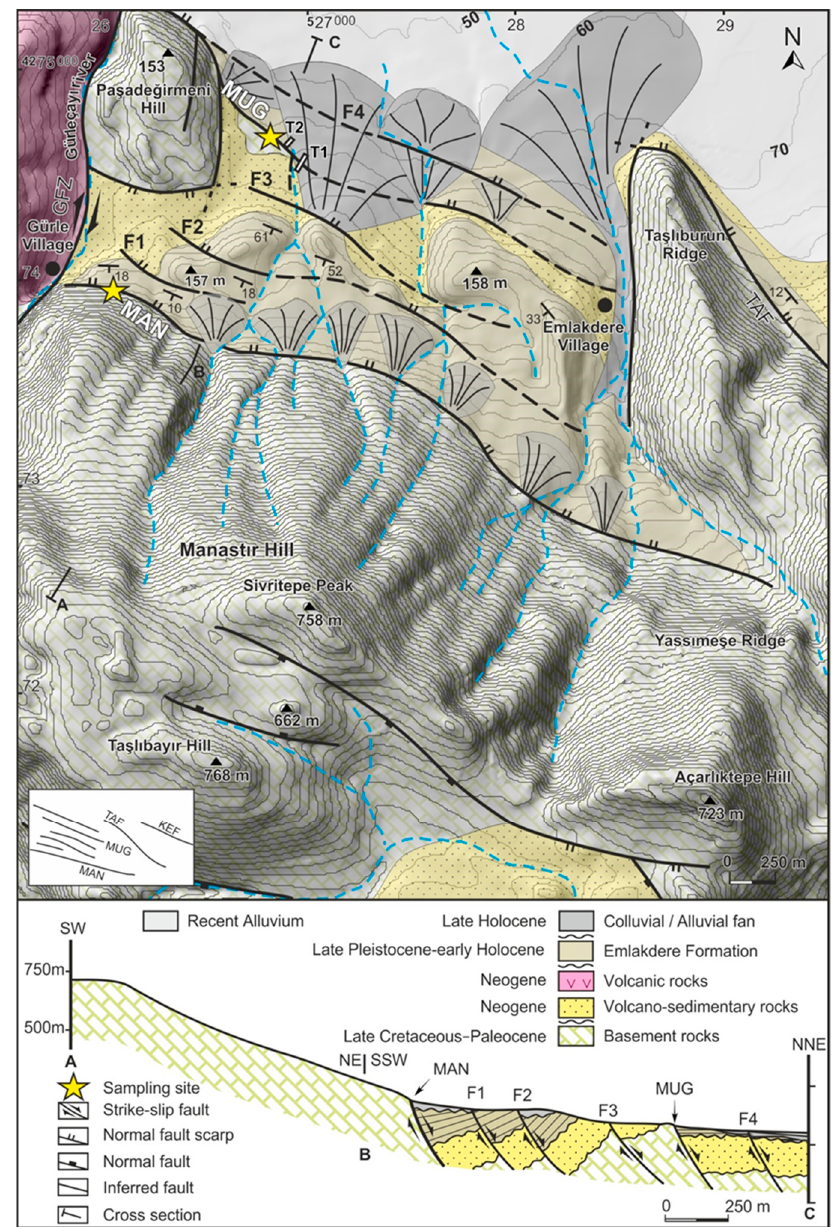
Figure 3. Detailed geological map of the study area showing NW–SE-trending active faults; location of paleoseismological trench sites from [59] along Mugırtepe fault are shown as T1 and T2. Yellow stars locate fault scarp dating sampling sites of Manastır (MAN) and Mugırtepe (MUG) faults, respectively. GFZ: Gürle Fault Zone, TAF: Ta¸slıburun fault, KEF: Keçiliköy fault; Inset is a simple sketch to show Ta¸slıburun fault, which its location is beyond the map frame. Geological cross section shows stratigraphic and structural relationships of the units. Note that offset of Quaternary deposits by several instances of synthetic Holocene faulting in the hangingwall of the Manast ı r fault is the most direct evidence for their activity (modified from [24,59]).